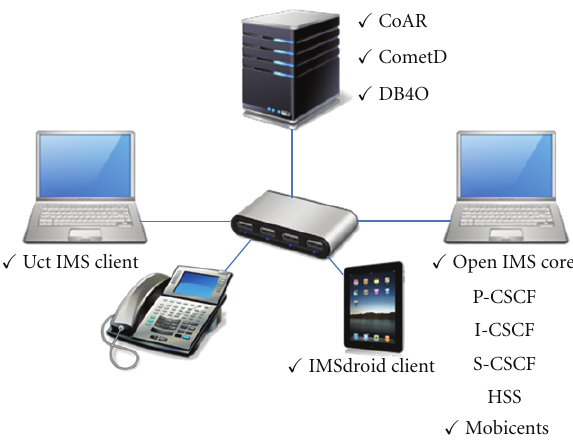
Figure 6: Test environment.